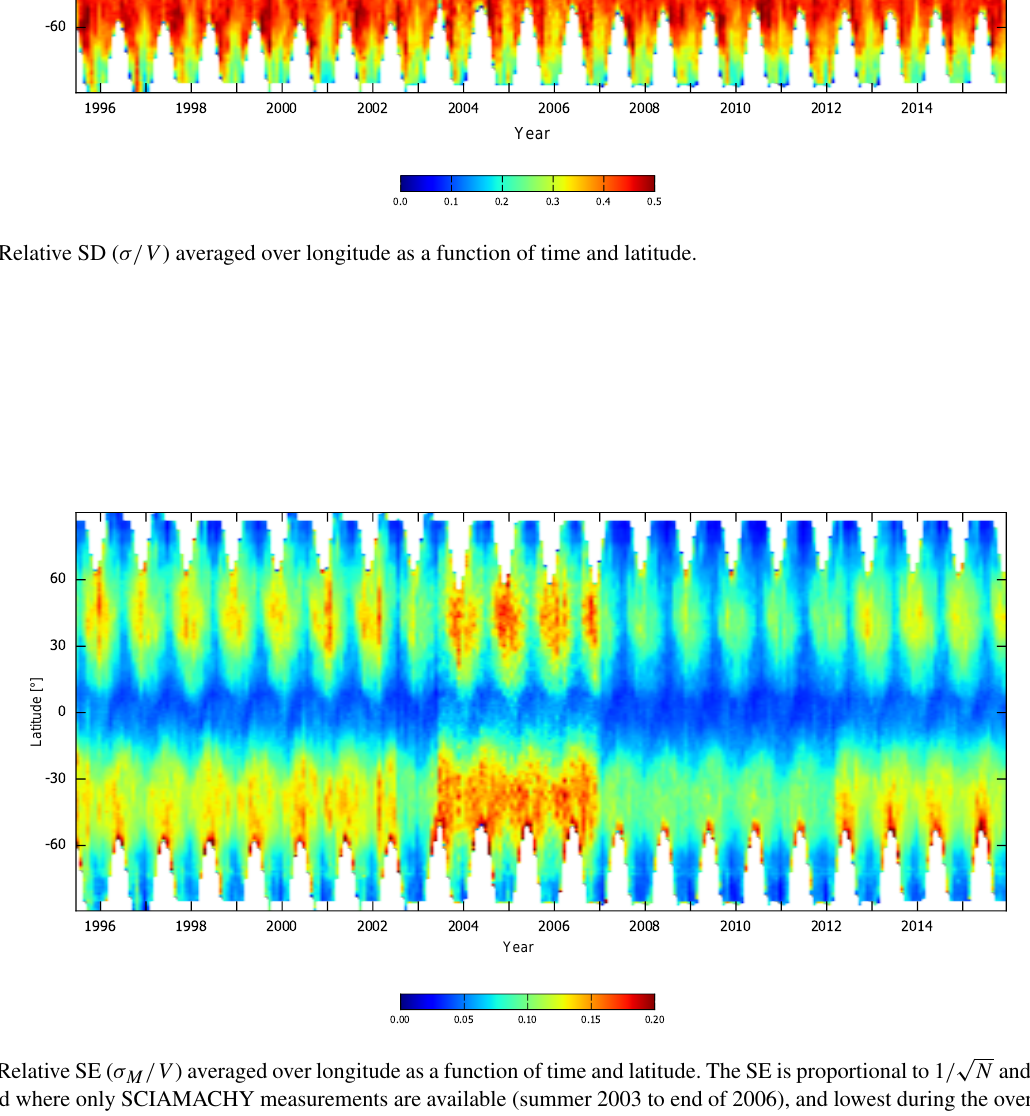
Figure D3. Relative SE ( σ M /V ) averaged over longitude as a function of time and latitude. The SE is proportional to 1 / for the period where only SCIAMACHY measurements are available (summer 2003 to end of 2006), and lowest during the overlap periods.